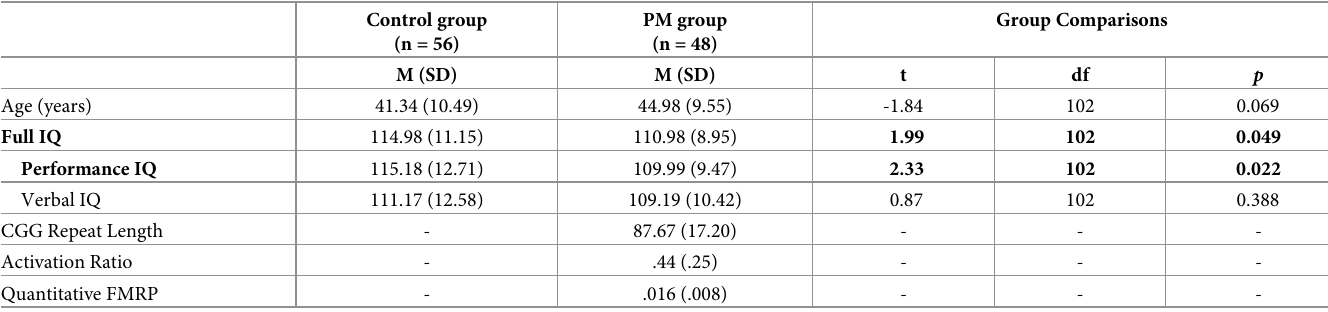
Table 1. Characteristics of the